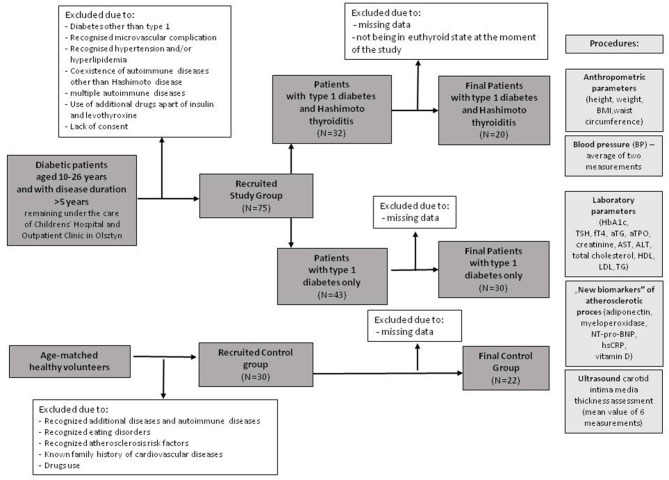
The flow chart of the selection for the study groups.